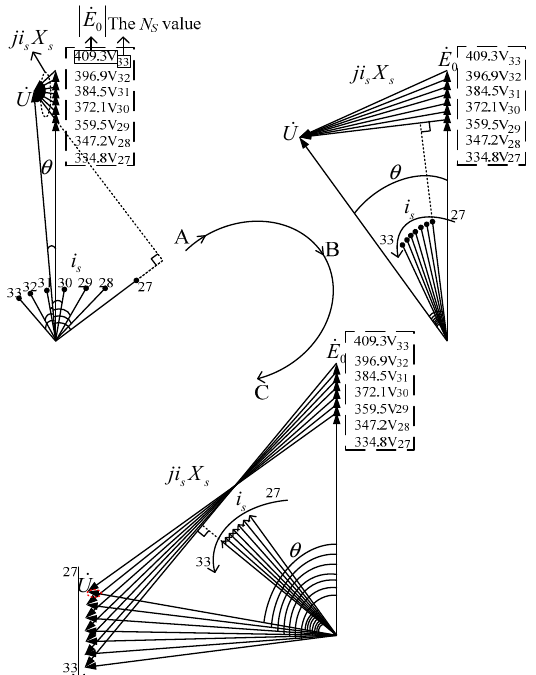
Figure 6. Phasor diagram with different N S values under different loads.